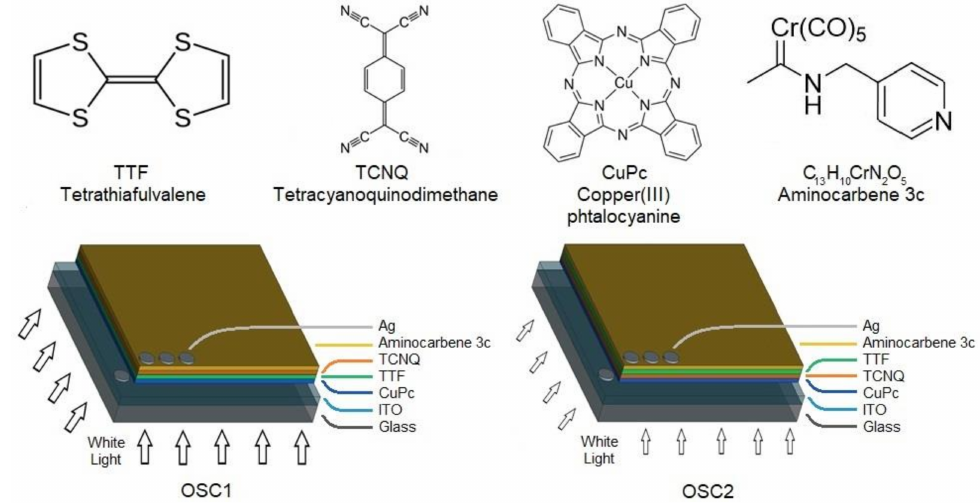
Figure 7. Schematic diagram of the configuration of the two OSCs constructed and the molecular structures of the materials